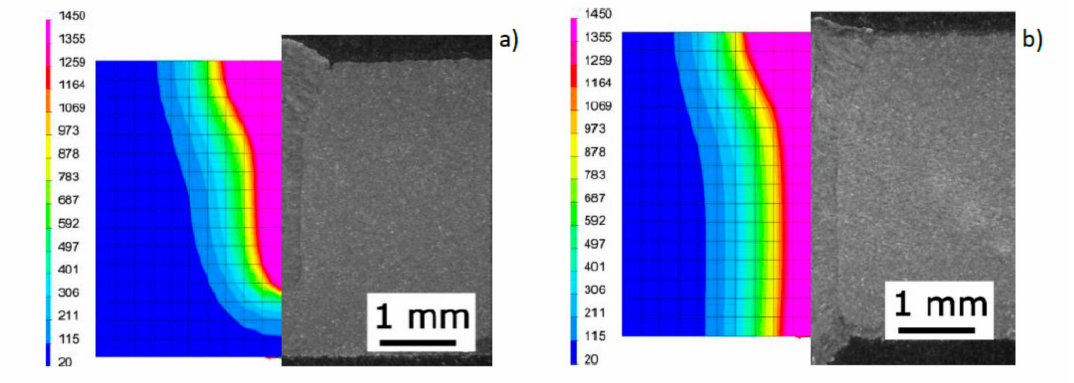
Figure 16. Comparison of the bead shape in the cross-section of sample ( a ) DL_TC3 and ( b ) DL_TC4 with the results of numerical analyses (Table 3).